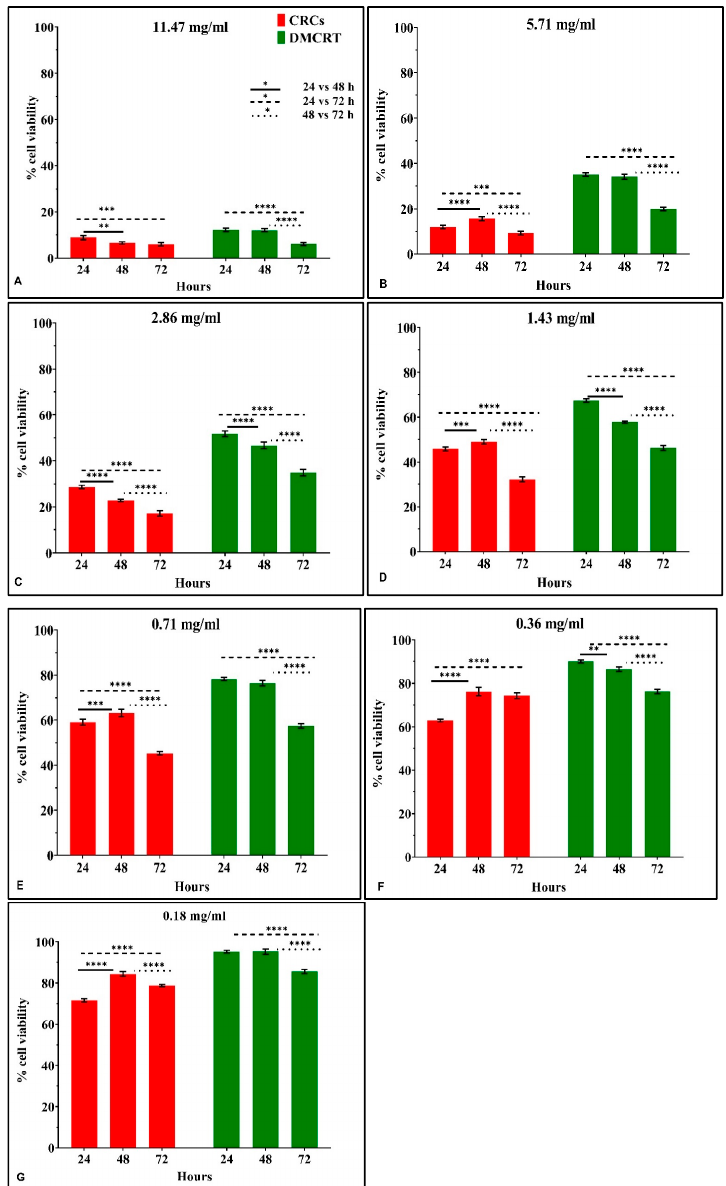
Figure 9 . Time-dependent effect of CRCs and DMCRT on TE671 cells. Time-dependent effect of CRCs and DMCRT at concentrations 11.429 mg/mL ( A ), 5.174 mg/mL ( B ), 2.857 mg/mL ( C ), 1.429 mg/mL ( D ), 0.714 mg/mL ( E ), 0.357 mg/mL ( F ), 0.18 mg/mL ( G ) ( Legend : CRCs : Crocins, DMCRT : dimethylocrocetin. Asterisks (*) depict at least p < 0.05 significance level between control experi- ments and CRCs (* p < 0.05; ** p < 0.01; *** p < 0.001; **** p < 0.0001). Each value represents the mean ± S.D. of triplicate experiments. Similar to A172 cells, the first derivative of cell viability with respect to individual concentrations was calculated. Cells exposed to CRCs manifested a higher cytotoxicity rate for concentrations between 0.714 mg/mL and 2.857 mg/mL (Figure 10A), whereas DMCRT manifested a quasi-normal distribution, with higher cell cytotoxicity rates at 1.429 mg/mL (Figure 10B). TE671 cells exposed to CRCs manifested three concentrations with similar effectiveness (0.71, 1.43 and 2.86 mg/mL), indicating three concentrations which are more time-dependent (Figure 9A). In addition, the cells manifested two con- centrations (0.18, 0.36 mg/mL), with positive derivative, indicating that cells recovered during treatment (Figure 9A). At the same time, cells exposed to the higher concentrations (5.71, 11.43 mg/mL) manifested a derivative close to zero, indicating a dose-dependent effect, as cell viability at 72 h was close to cell viability observed at 24 h (Figure 9A). On the other hand, DMCRT manifested a normal-like distribution with respect to the first derivative (Figure 9B) and the most effective concentration identified was 1.43 mg/mL. Additionally, concentrations 0.71 and 2.86 mg/mL manifested similar behavior,